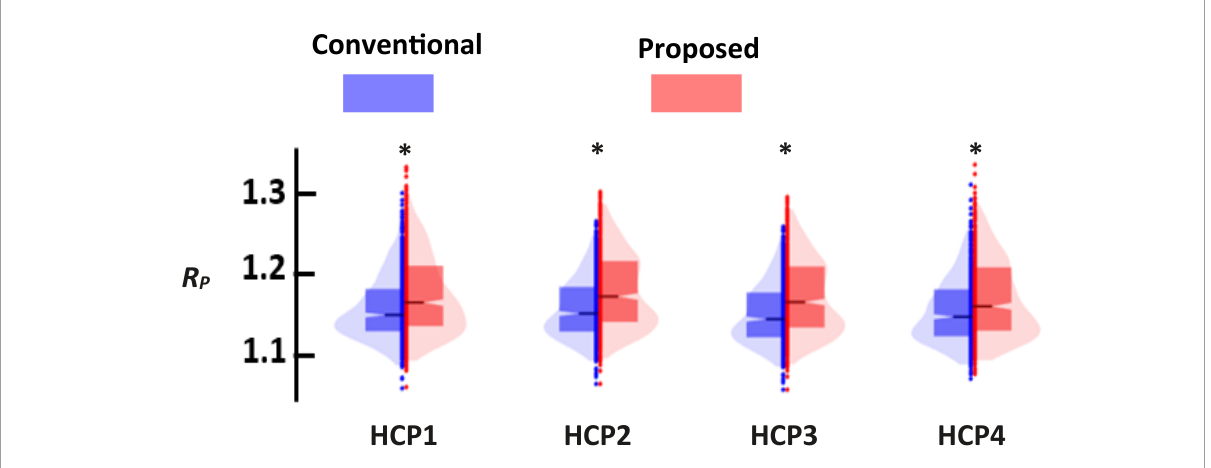
FIGURE7 The comparison of the cluster quality between standard (blue) and proposed (red) approach. Each column represents that result of each session. In all comparisons, proposed dFNC pipeline had higher cluster quality ( p < 0 . 001, N = 833). Asterisk (*) represents a significant different between the clustering quality based of old and